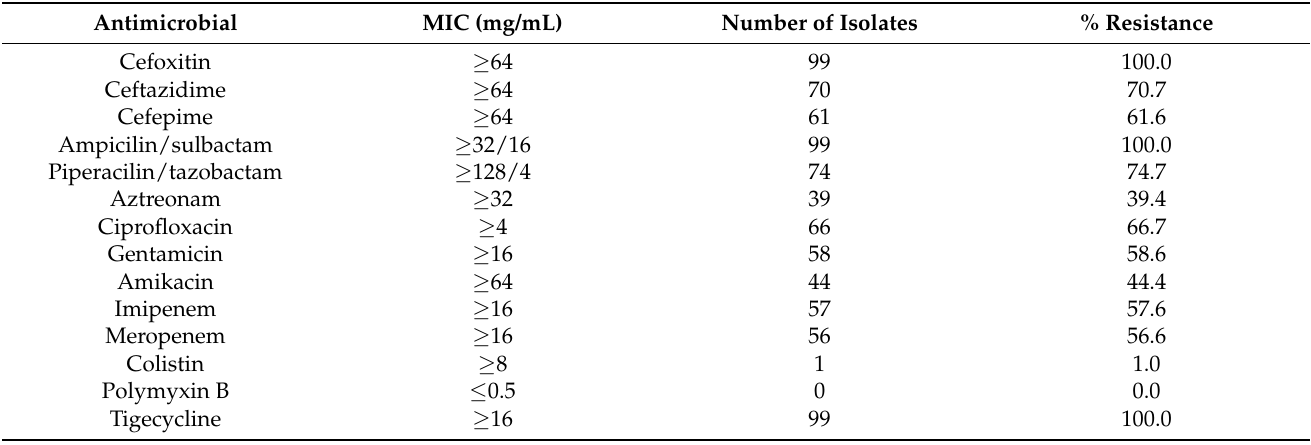
Table 4. Antibiotic resistance profile of Pseudomonas aeruginosa isolates evaluated in this study as determined by the Vitek 2 Compact